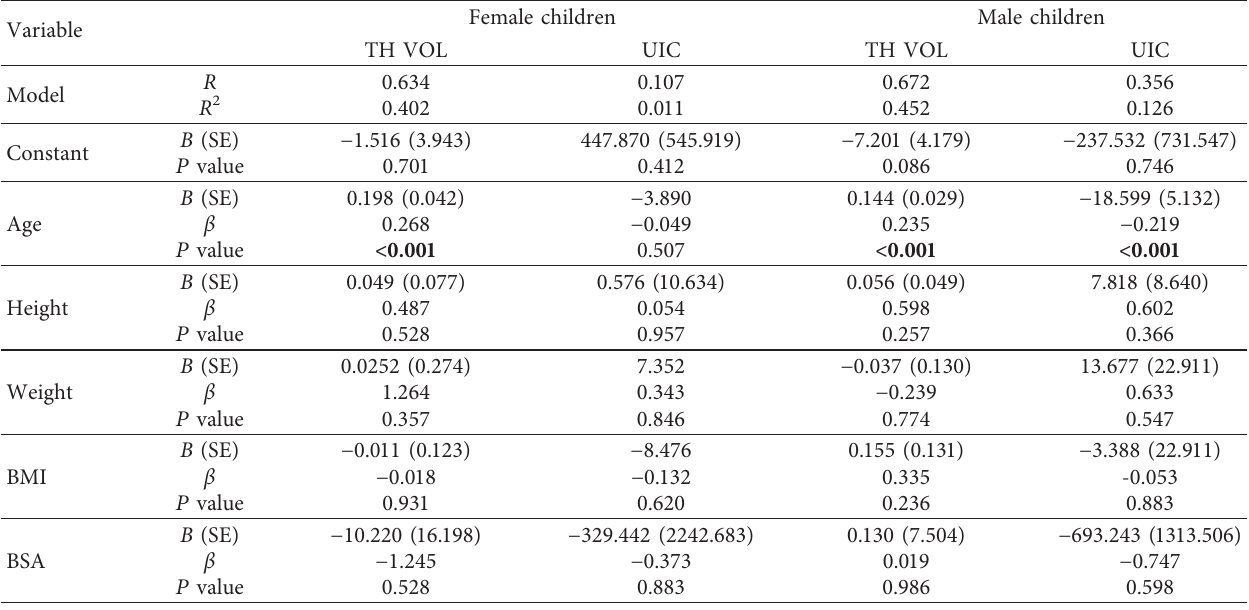
Table 2: Multiple linear regression of age, height, weight, BMI, and BSA with thyroid volume and UIC. Variable